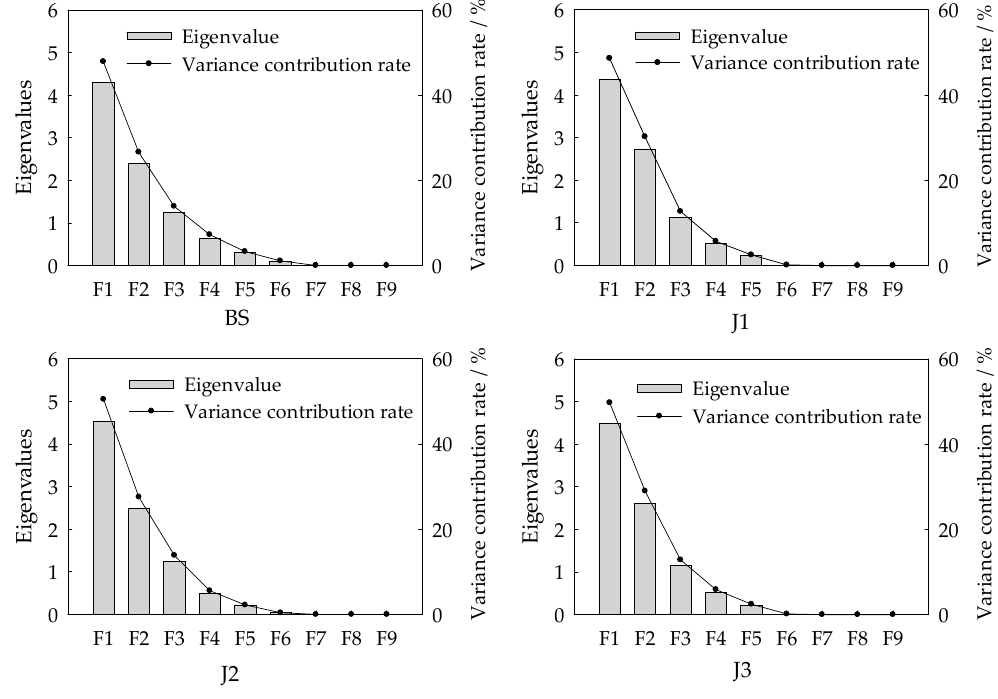
Figure 9. Variance contribution rates and eigenvalues in P3. Table 5. Weight coefficient of factors in F1 during the thawing stage (P3).